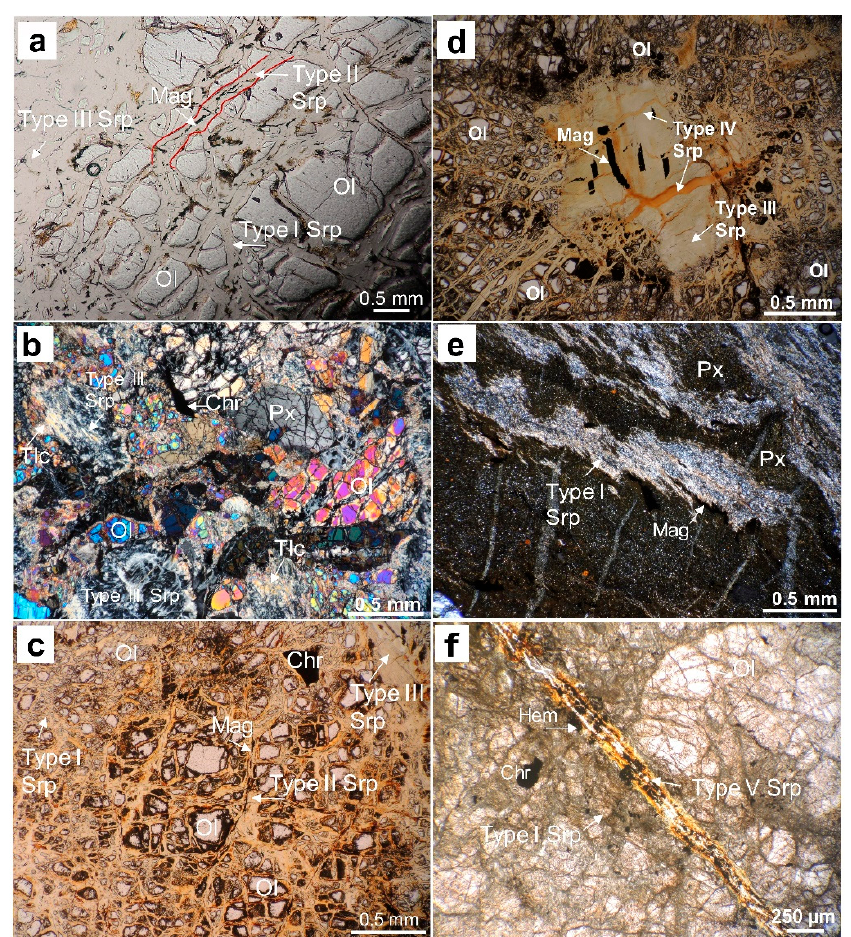
Figure 6 . Photomicrographs of ( a , b ) type I, II and III serpentine veins cutting primary olivine, pyroxene, chromite, and Fe-oxide in lherzolite (BB2515 core); serpentine veins in the saprock developed above ( c ) lherzolite (BB2515 core), ( d ) harzburgite-dunite (BB2406 core), and ( e , f ) clinopyroxenite (PG1500